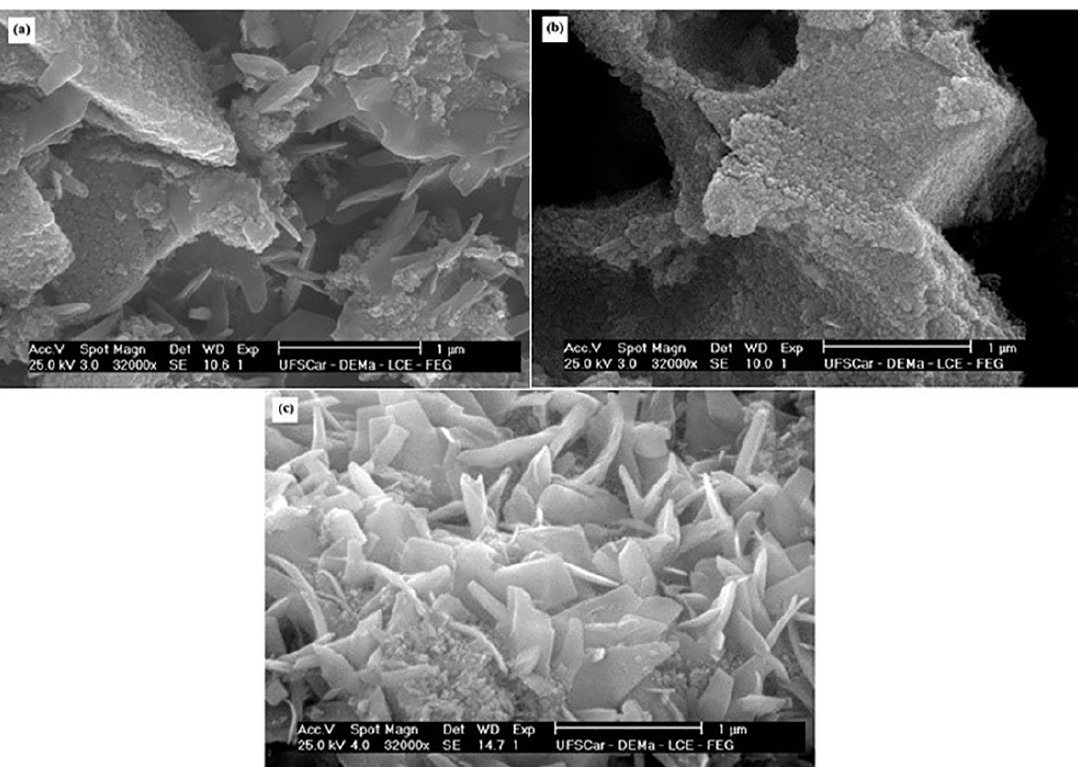
Mn O prepared by the Pechini method and calcined at 500°C: (a) Zn 1-x x